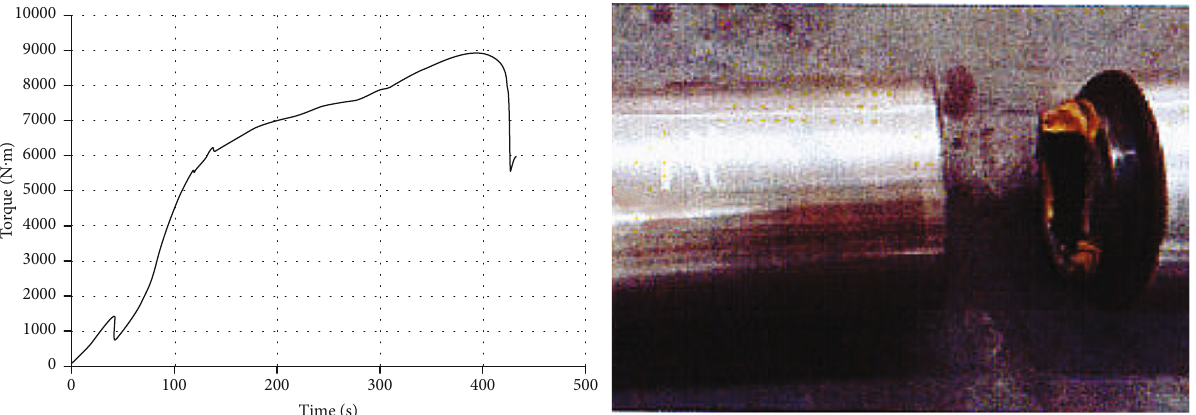
Figure 9: Torsion resistance test of the bionic drill pipe.